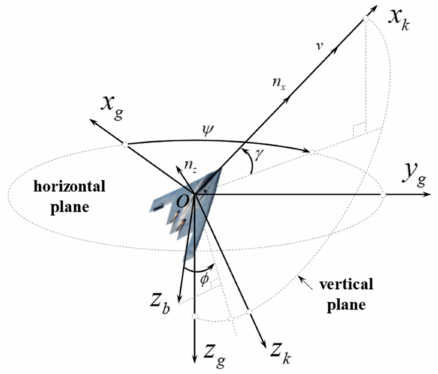
Figure 1. UCAV motion